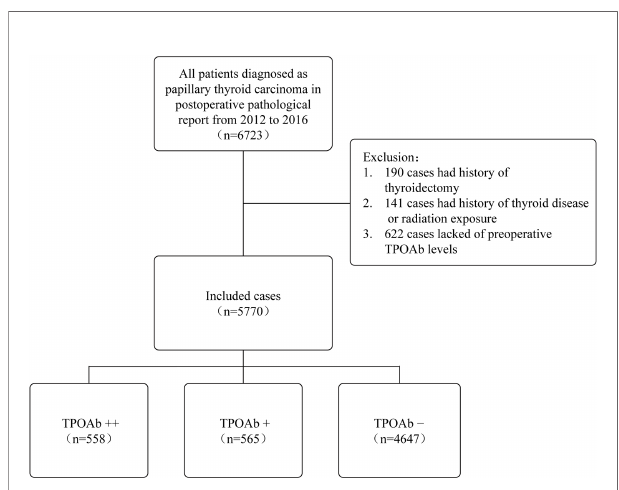
FIGURE 1 | Case selection process for this study. TPOAb, thyroid peroxidase antibody; TPOAb − , 0 < TPOAb ≤ 100 IU/L; TPOAb+, 100 < TPOAb ≤ 1,000 IU/L; TPOAb++, TPOAb > 1,000